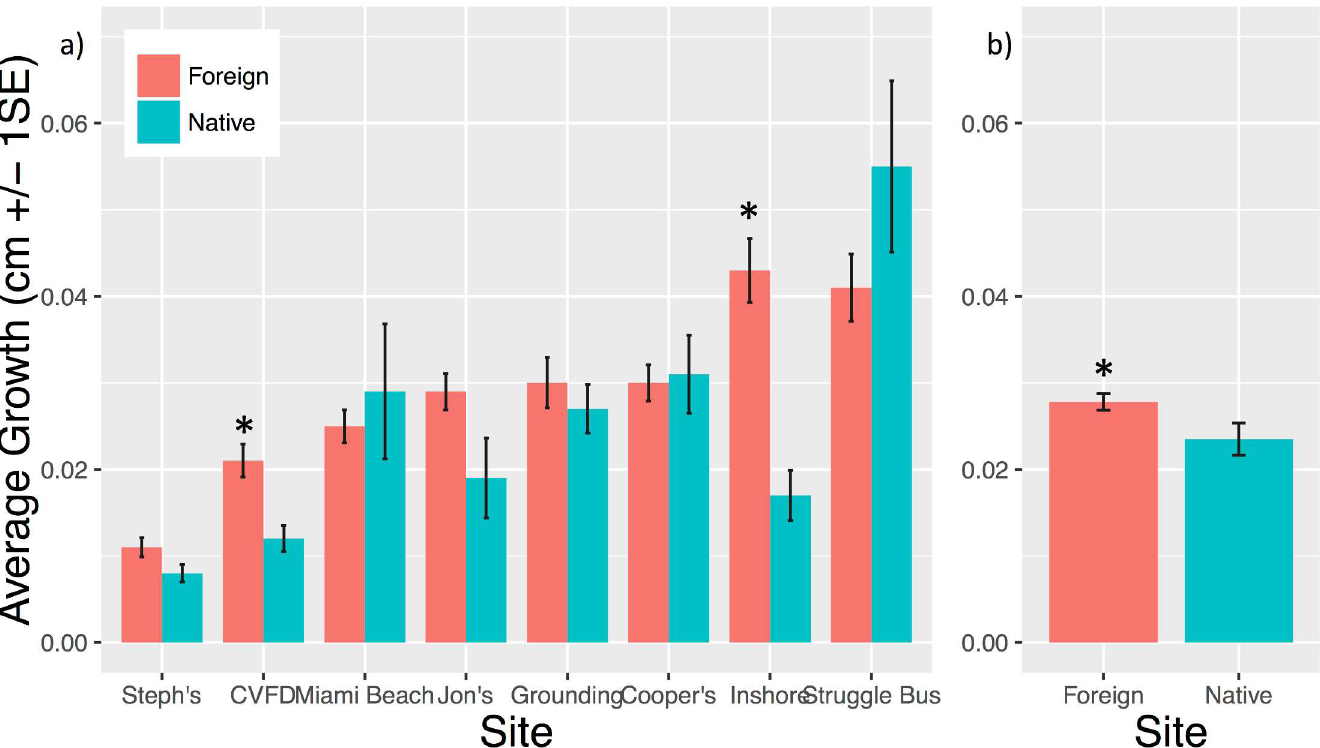
Fig 3. Local adaptation comparisons of growth. (a) Average growth (cm/day +/- 1 S.E.) of local and foreign corals at each site. Significantdifferences betweenlocal and foreign genotypes within a given site are denotedby * (t-test p < 0.05).Higher growth in foreign corals suggestslack of local adaptation among native genotypes at any given reef. (b) Average growth of native and foreign corals pooledacross all sites, significantdifferences betweennative and foreign are denotedby * (t-test p < 0.05).Local corals were wild controls plus corals originallycollectedfrom each site before propagationin the nursery. Foreign corals are genotypes collectedfrom all other